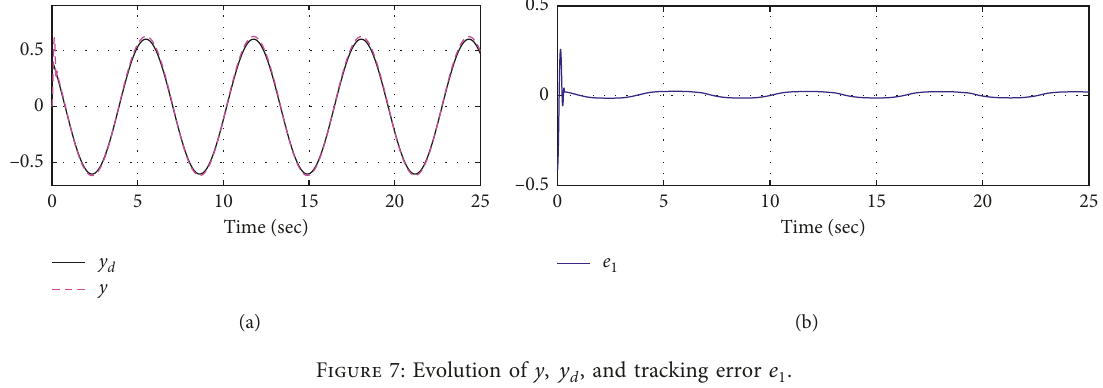
d , and tracking error